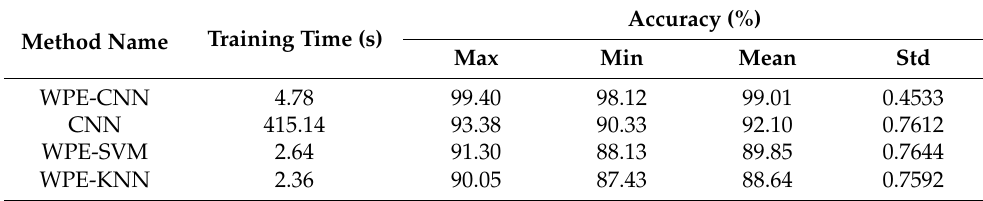
Table 7. Comparison of training time and accuracy of three models.